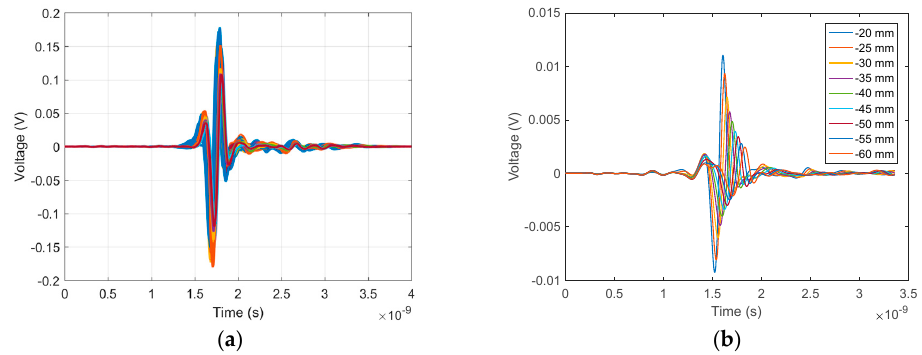
Figure 7. ( a ) Overlay of all 140 skin responses recorded during a volunteer scan. ( b ) Overlay of nine skin responses recorded during a volunteer with the previous prototype. All skin responses in ( b ) are for the same azimuth but at different depth from the chest wall to the nipple.